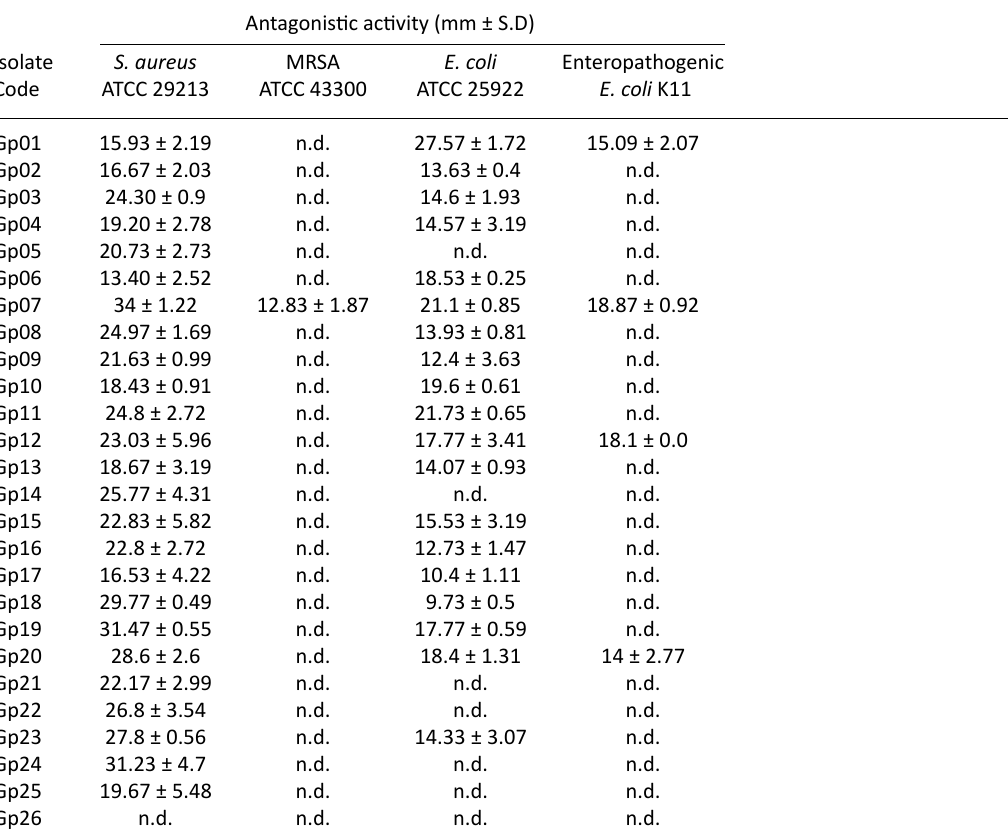
Table 2. Antagonistic activity of endophytic fungi isolated from Globba patens Miq. rhizome Antagonistic activity (mm ± S.D) Isolate S. aureus MRSA E. coli Enteropathogenic Code ATCC